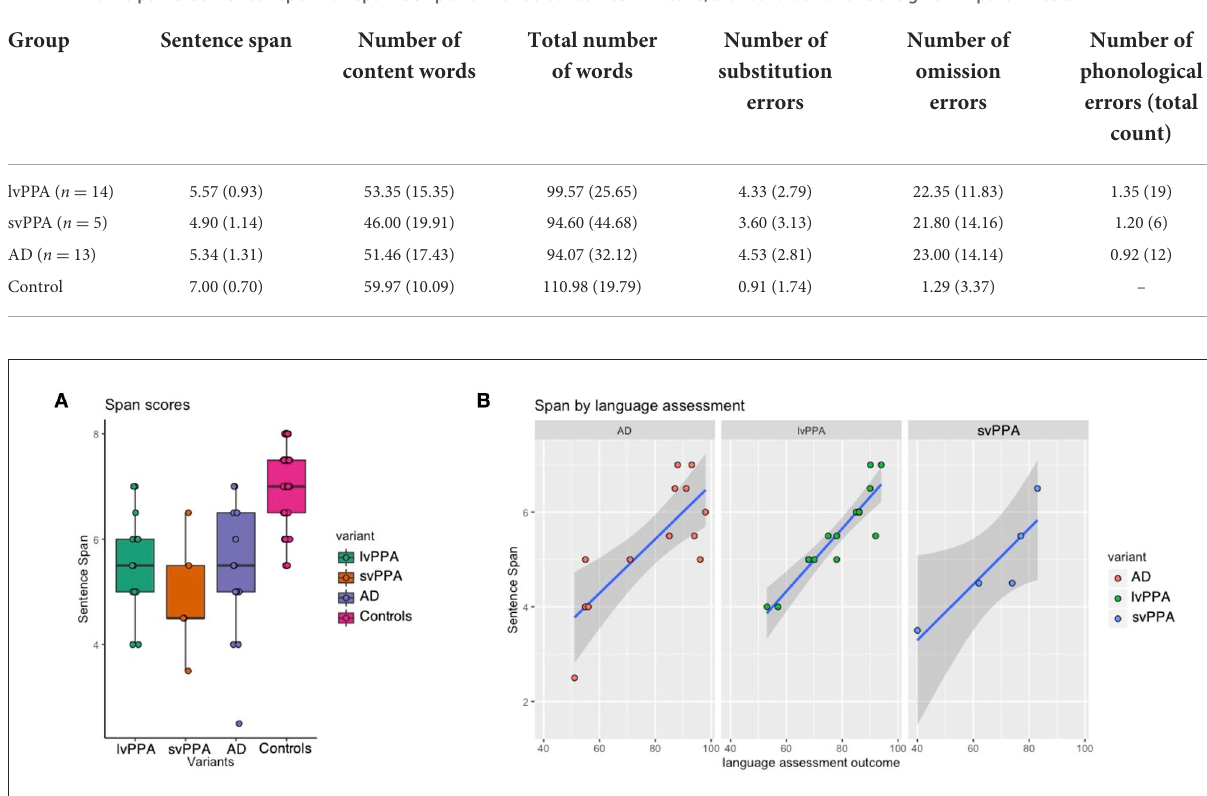
FIGURE1 (A) Boxplot showing group performance across the three diagnostic groups points show individual performance; (B) Scatter plots demonstrating the relationship between span scores and language assessment